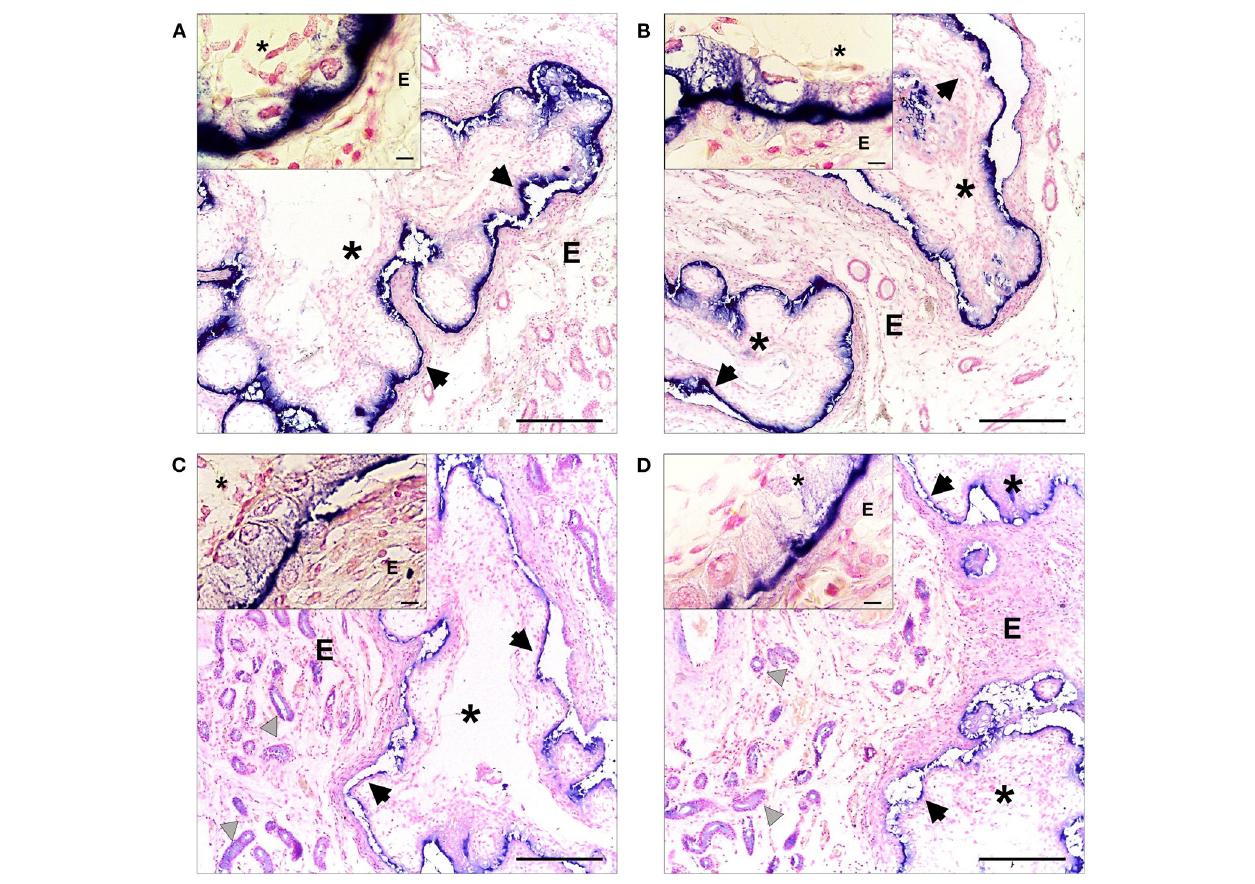
FIGURE 4 | Immunohistochemical localization of β -NGF (A,B) and TrKA (C,D) in the endometrial mucosa of 30 days-pregnant alpacas, positive labeling gives a blue-violaceous coloration. 100-fold magnification (bar = 100 µ m) of left uterine horn (A,C) and right uterine horn (B,D) . In addition, inset shows a magnification of the extraembryonic membranes (bar = 10 µ m). E: endometrium, asterisks: extraembryonic membranes, black arrows indicate the positive immunolabeling on the extraembryonic membranes, gray triangles indicate positive TrKA immunostaining in glandular epithelium and